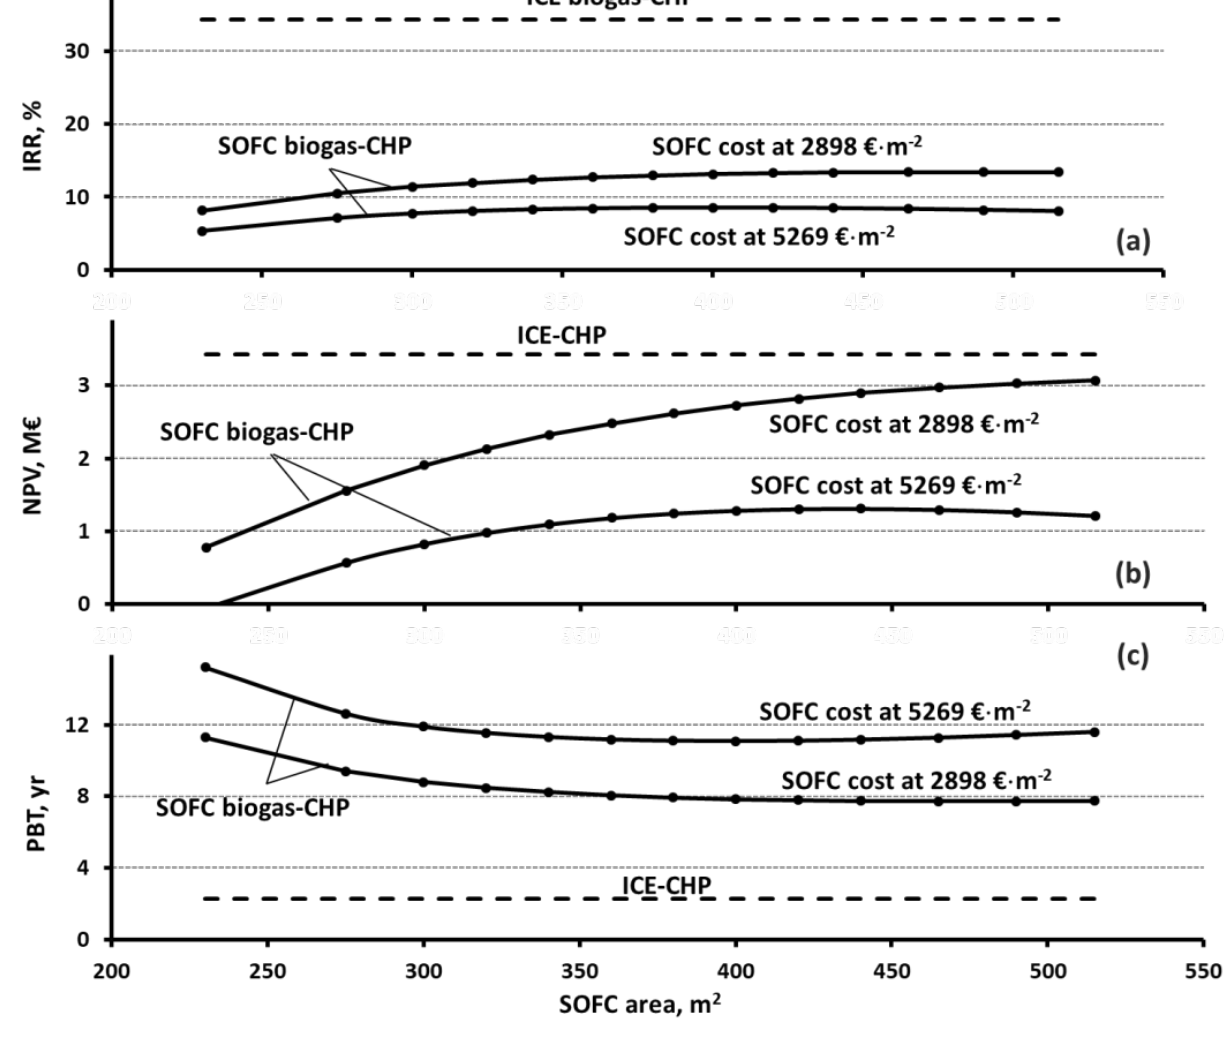
Figure 7. Dependence of: ( a ) IRR, ( b ) NPV and ( c ) PBT of the smaller scale biogas plant (250 m 3 · h − 1 biogas), on the size of the employed SOFC unit and its area specific cost, and their comparison to conventional biogas-CHP of the same biogas